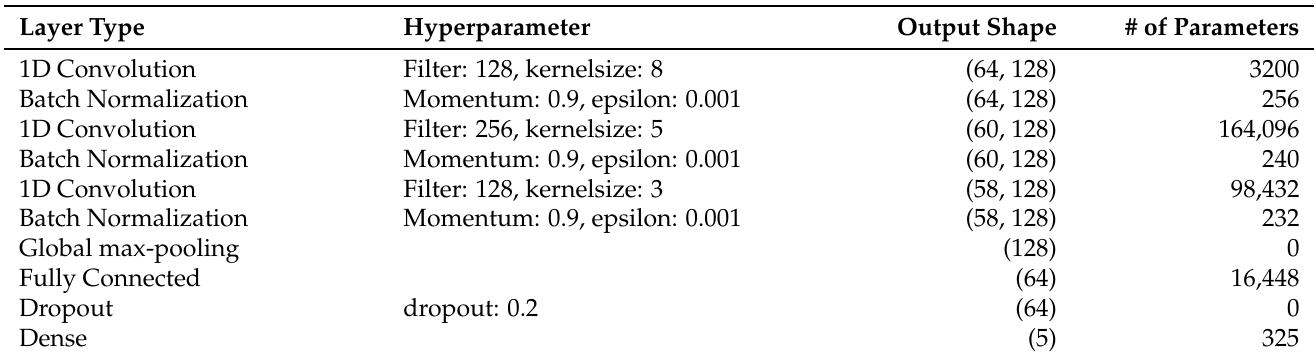
Table 3. Detailed description of the convolutional neural network used in this study. The first convolutional together with the batch normalization layers are used once for the acceleration data and once for the gyroscope